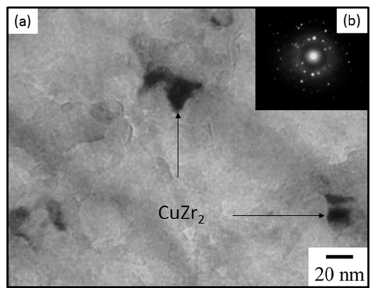
Figure 1. ( a ) Bright-field image of transmission electron microscope (TEM), and ( b ) diffraction pattern of the as-received (Zr 55 Cu 30 Ni 10 Al 5 ) 99.8 Sc 0.02 composite bulk metallic glass (BMG).